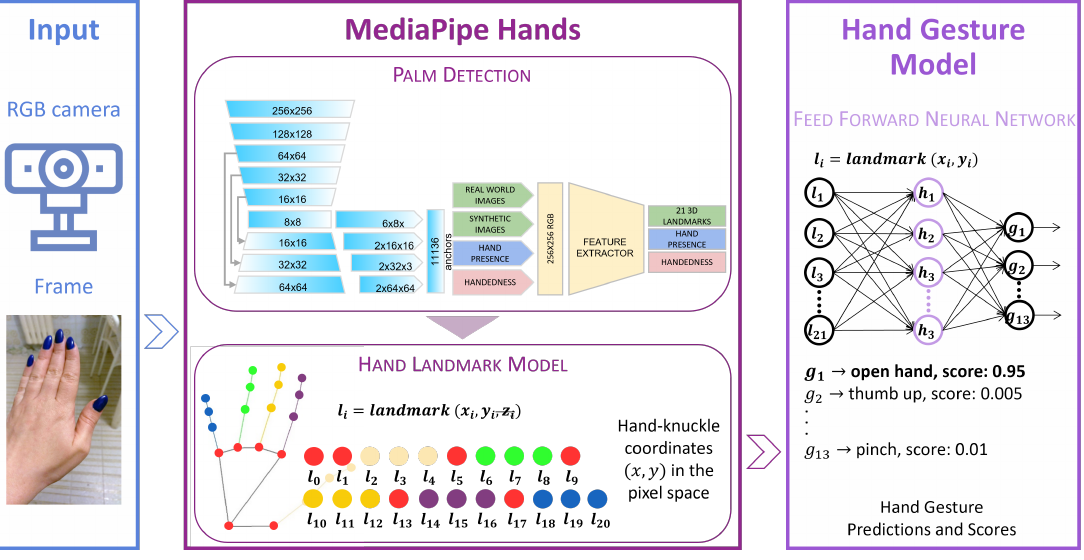
Figure 7. HGR System pipeline. Reproduced from